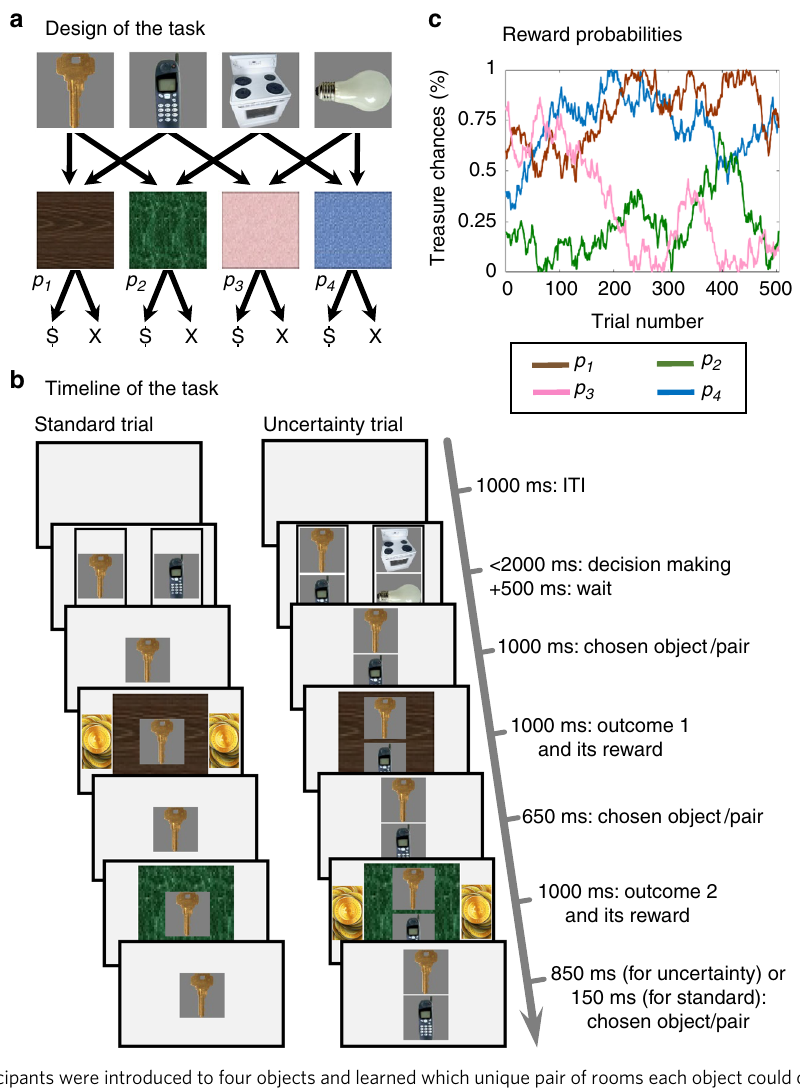
Fig. 1 Task Structure. a Participants were introduced to four objects and learned which unique pair of rooms each object could open. Each room was opened by either of two different objects. When opened, rooms probabilistically provided a one-point value treasure. b During standard trials (left) participants were asked to choose, within 2 s, one of two randomly-offered objects, and then visited sequentially the pair of rooms opened by that chosen object. At this point, participants discovered, for each room, whether it contained a treasure or was empty. In every third, uncertainty, trial (right), participants chose one of two object-pairs (left or right). Participants were instructed that a hidden hand (a ghost) would nominate one of the objects in their chosen pair randomly without revealing which. Participants then visited the pair of rooms that the object, nominated by the ghost, opened and earned whatever treasure was available in those rooms. Importantly, on an uncertainty trial, the fi rst outcome was common to both objects in the chosen pair and hence did not support an inference about the ghost ’ s nomination. The second outcome, however, was unique to the ghost-nominated outcome and hence, allowed an MB retrospective inference with respect to the ghost ’ s nomination. We hypothesized that participants not only inferred the ghost ’ s nomination but that in addition this inference would guide the expression of MF learning. This in turn leads to a speci fi c prediction that MF learning will be stronger for a ghost-nominated object compared to a ghost-rejected object. c Across trials, reward probabilities for the four rooms drifted according to independent Gaussian random walks with re fl ecting bounds at 0 and 1. Images adapted from the stimulus set of Kiani et al. 2007, ref.